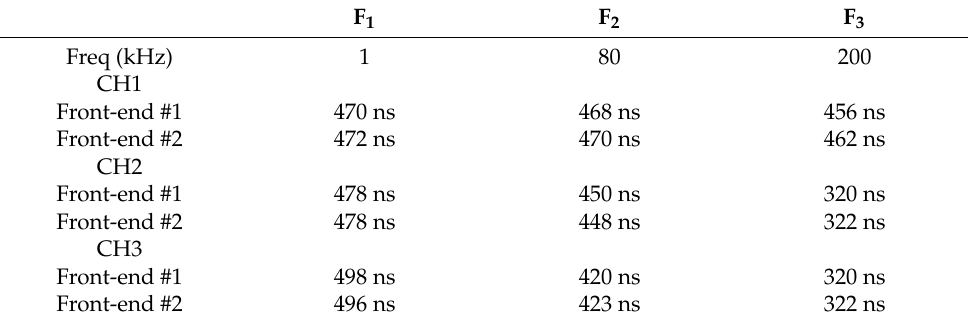
Table 4. Delay times for the three channels of the AFE.